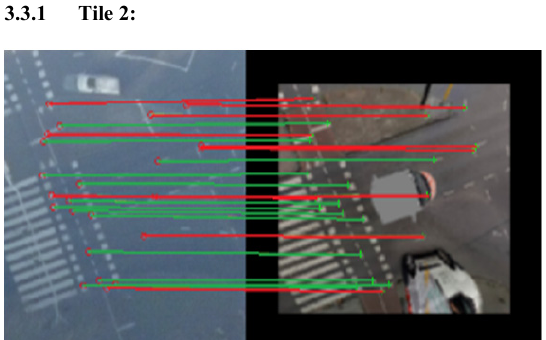
Figure 6. AGAST/SURF matching result of 2 nd tile